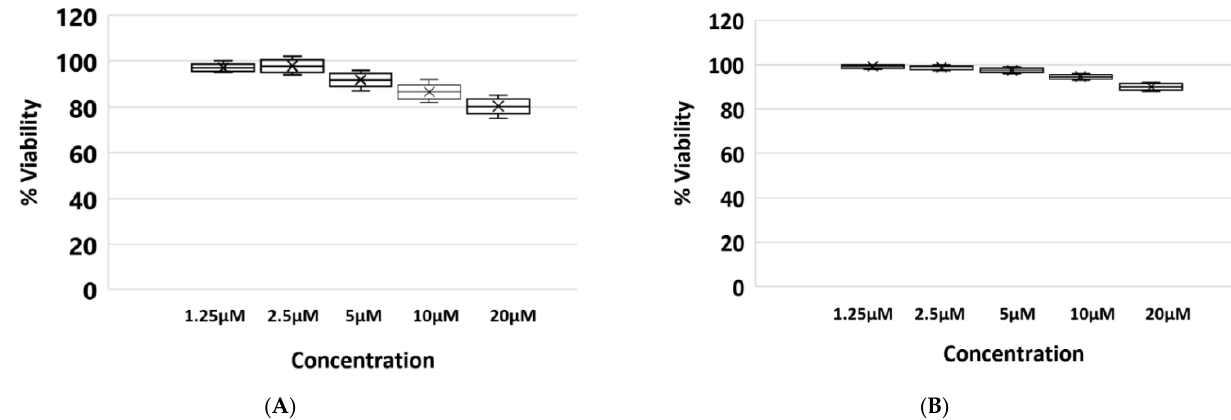
Figure 2. Effect of fluvastatin on cell viability. ( A ) Effect of increasing concentrations of fluvastatin on BSR cell viability. Cells were harvested at 72 h post-treatment and assessed by an MTT viability assay. ( B ) Effect of increasing concentrations of fluvastatin on KC cell viability. Cells were harvested on day 5 post-treatment.